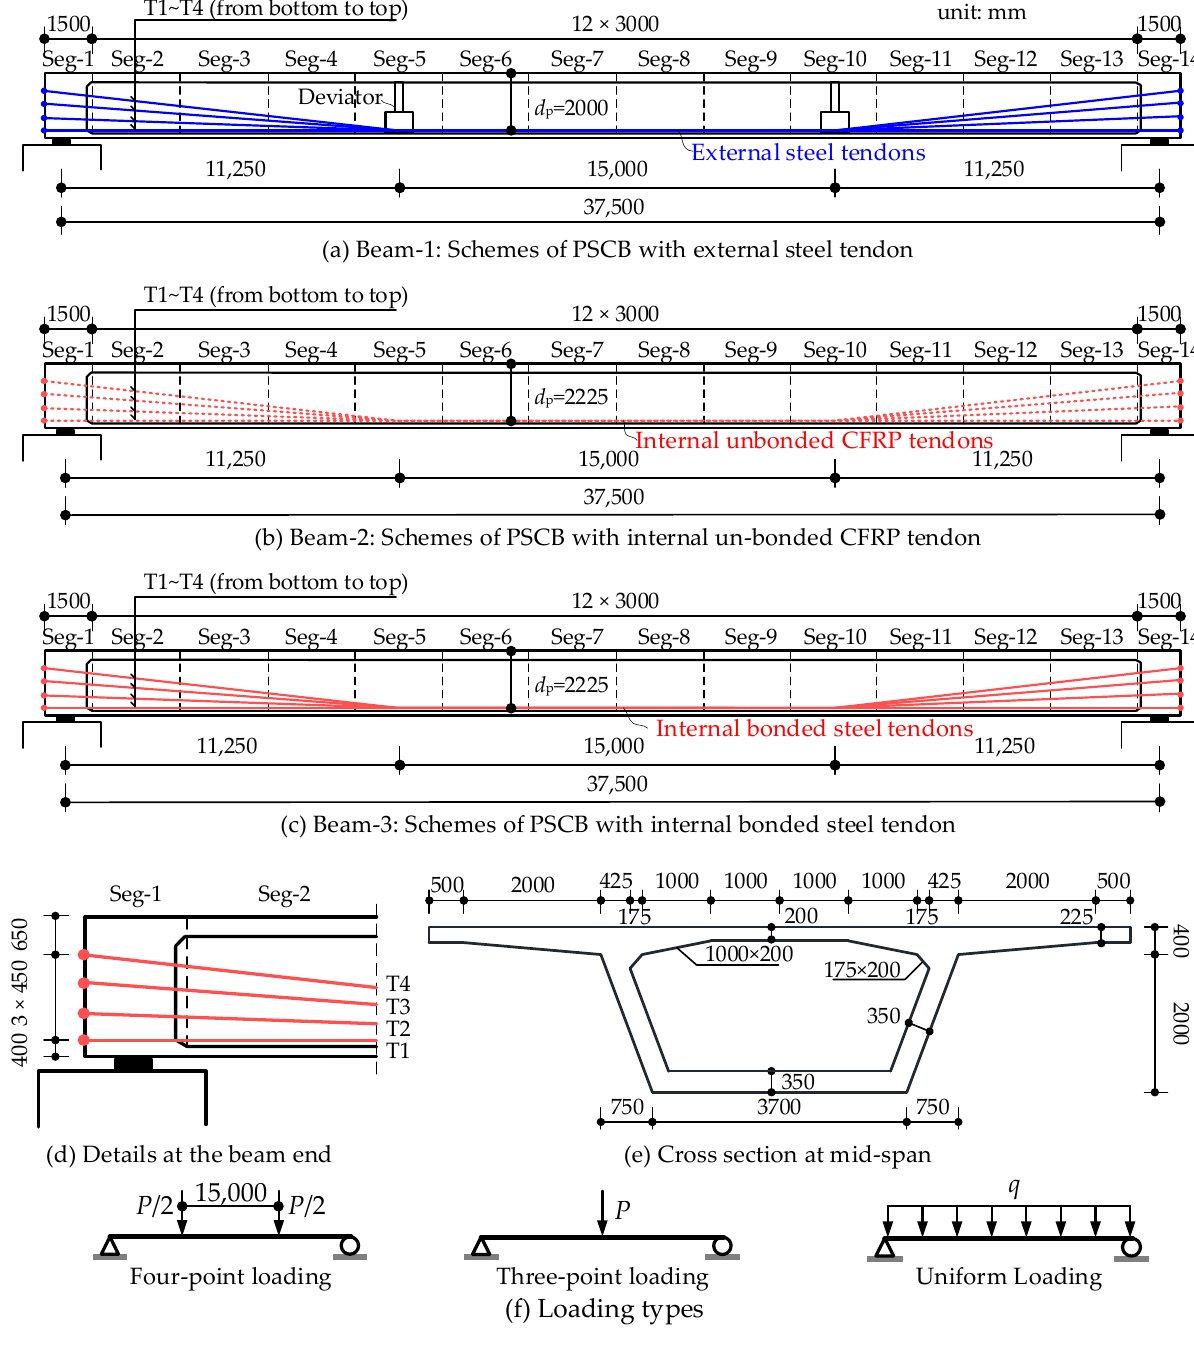
Figure 13. Structural dimensions of the numerical beam (unit: mm).